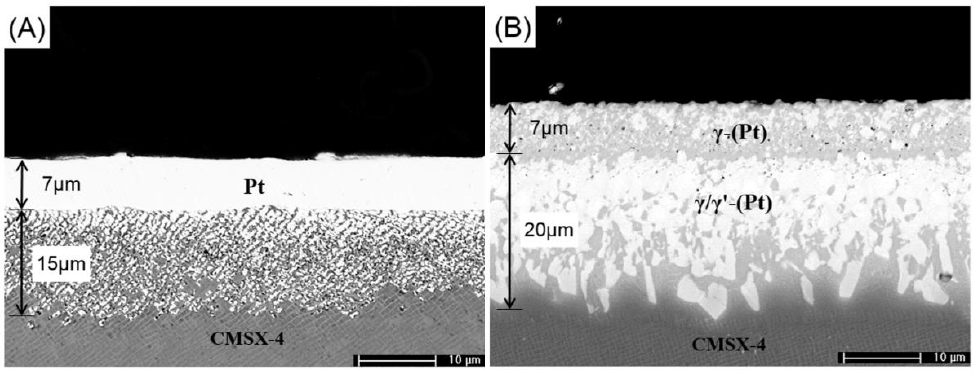
Figure 6. Cross-sectional BSE images of the ( A ) as-electroplated γ’-etched substrate and ( B ) after heat treatment at 1150 °C for 2 h in vacuum.